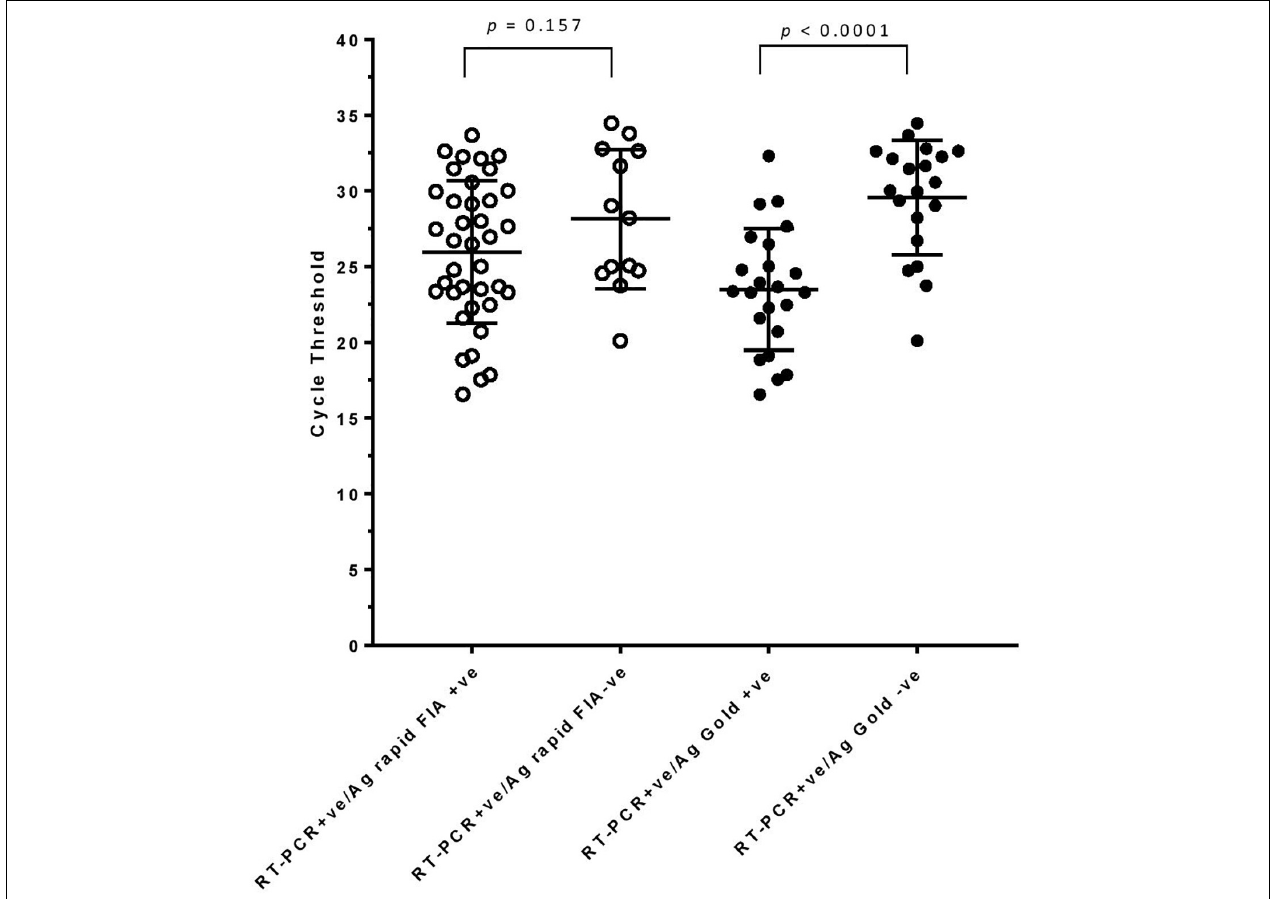
FIGURE 2 | rRT-PCR cycle threshold values (N-gene) in samples testing either Ag-RDT positive or negative. Mean (standard deviation) with p -values are